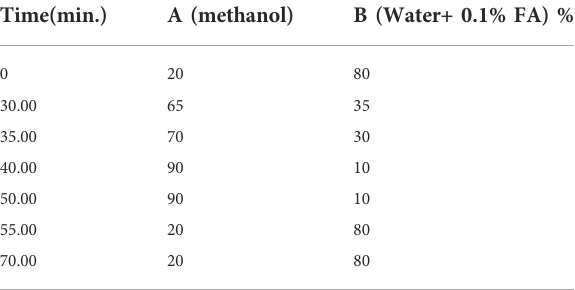
TABLE 1 S. apetala fruit extract HPLC gradient program.